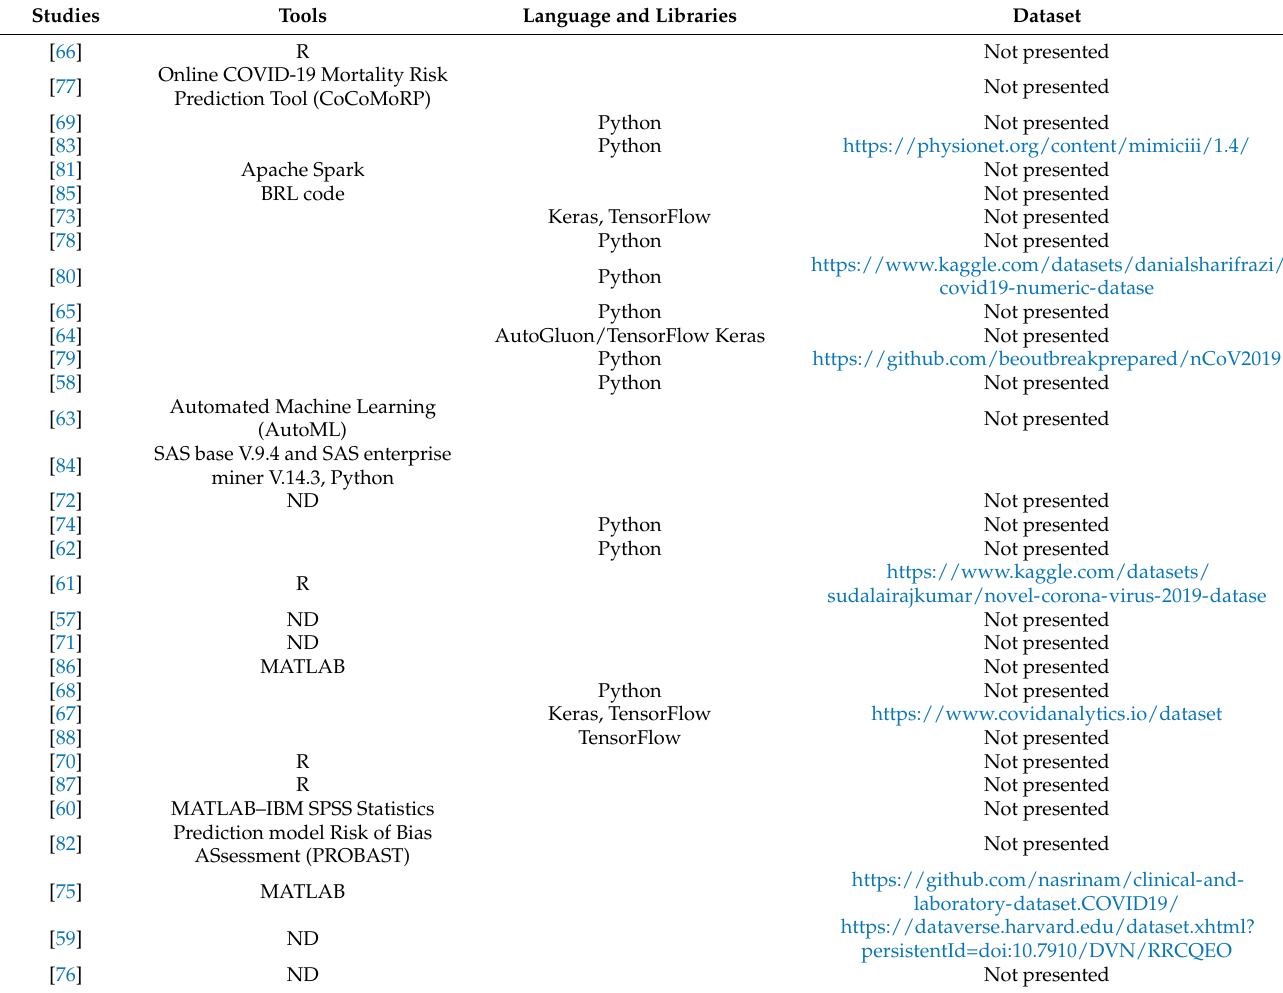
Table 9. Tools used for the implementation of the models designed in the works analyzed in the